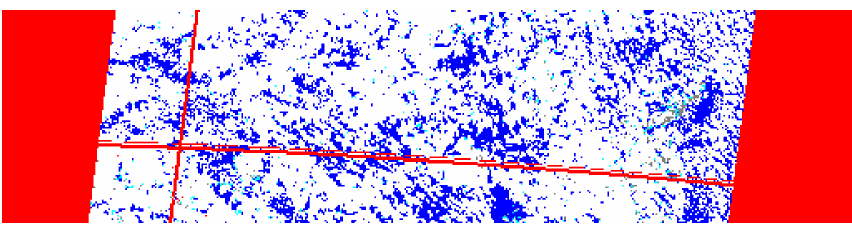
Figure 4. Map of the MISR RCCM for Path 168, Orbit 1412, Block 108 and camera BF. The linear dimensions of the mapped area and the color coding are identical to those indicated in Fig. 3.